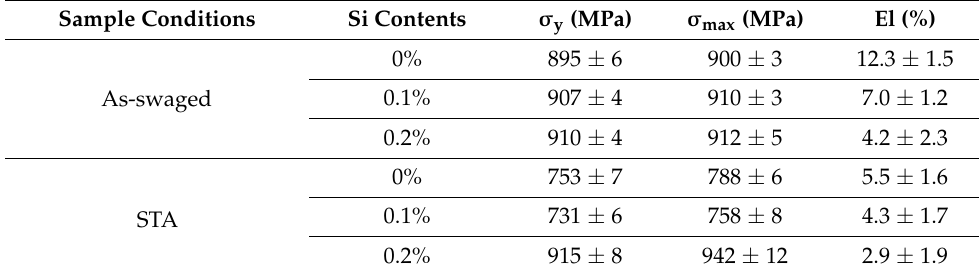
Figure 6. Tensile engineering stress-strain curves of STA-treated TNZ40 alloys: ( a ) TNZ40, ( b ) TNZ40 + 0.1 Si, and ( c ) TNZ40 + 0.2 Si. Table 1. Comparison of the tensile mechanical properties of the TNZ40 + x Si alloys: yield stress ( σ y ), ultimate tensile strength ( σ max ), and elongation